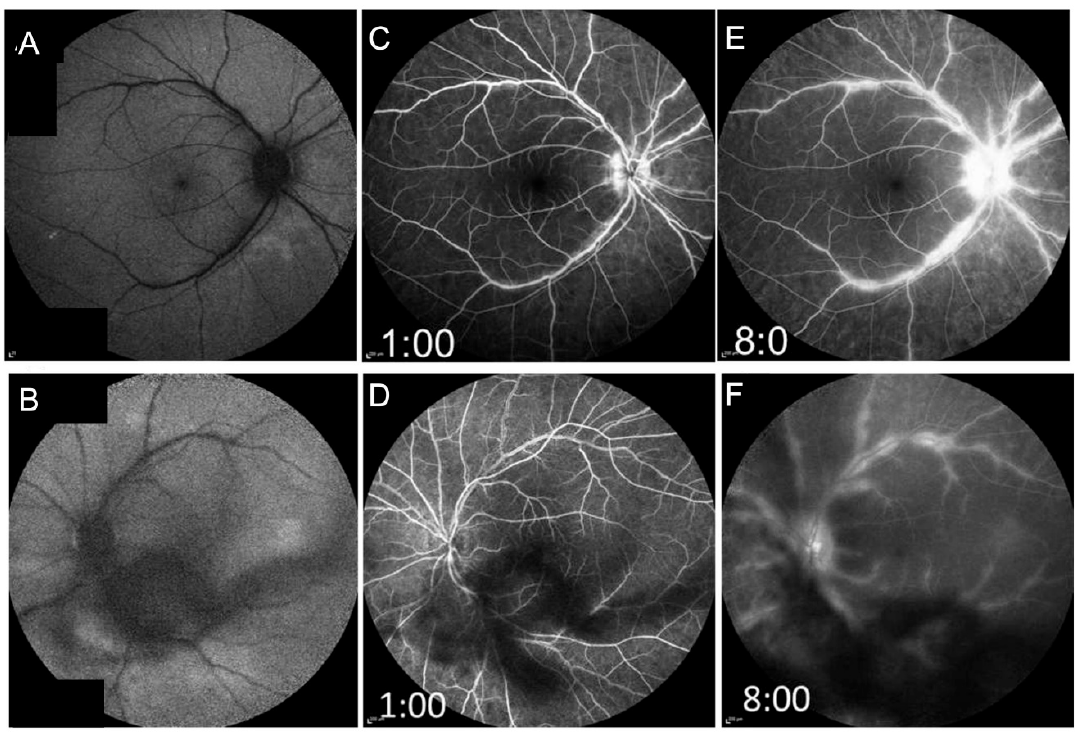
Figure 16. Fundus autofluorescence (FAF) and fluorescein angiography (FA) of the right and left eyes of the same patient with birdshot chorioretinopathy shown in Figures 14 and 15. The FAF is shown in ( A , B ) (right and left eyes, respectively). Early phase ( C , D ) and late-phase FA ( E , F ) of both fundi demonstrate leakage of the optic discs, large vessel leakage, and capillary ferning. Note: floaters are partly impairing visualization.